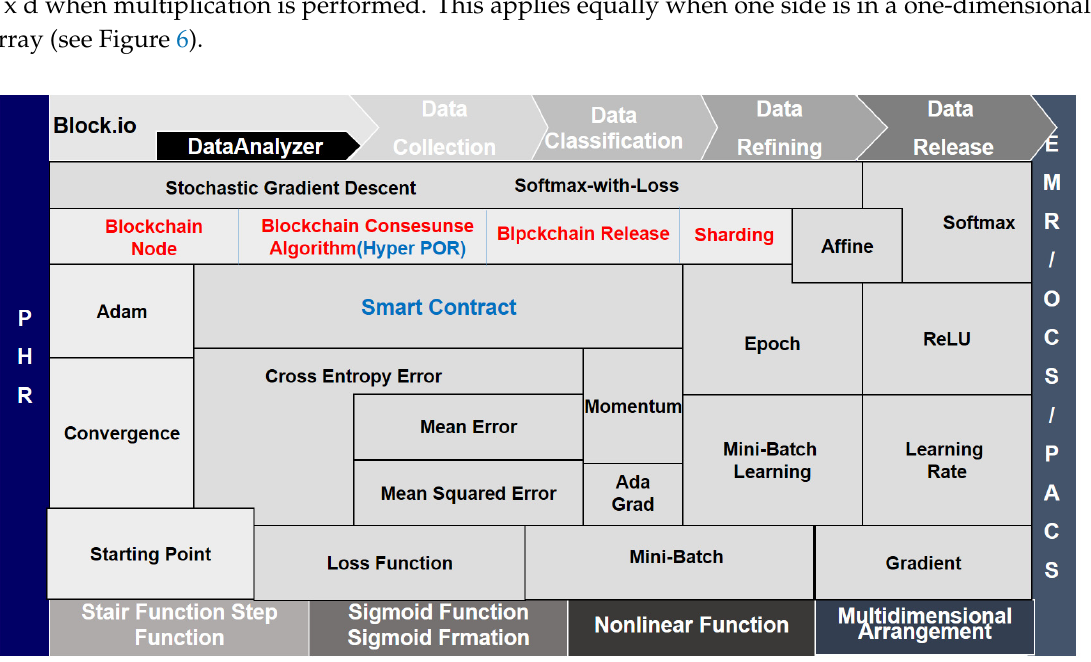
Figure 6. CNN (Convolutional Neural Networks) intelligent agent cloud architecture to increase healthcare data readings.